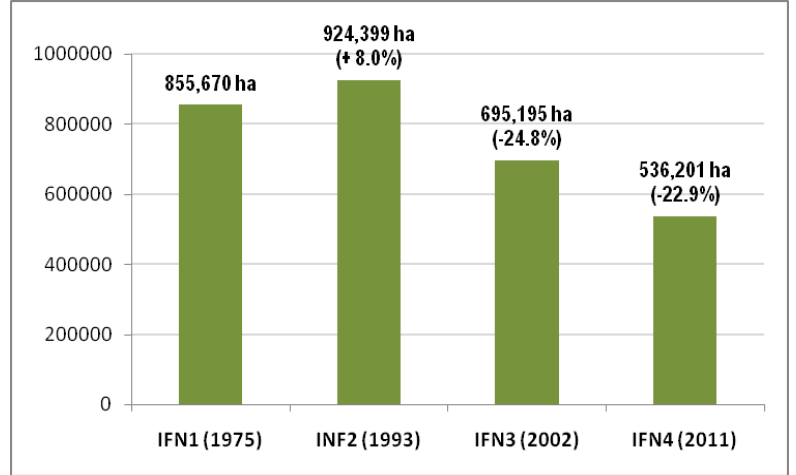
Figure 8. Change areas occupied by scrubs in Galicia according to Spanish Forest Inventories